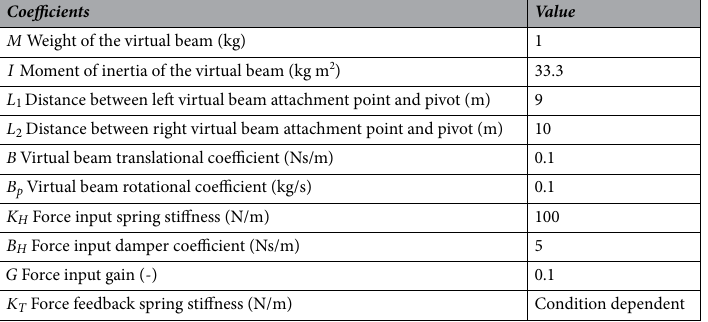
Table 1. Coefficients of the virtual